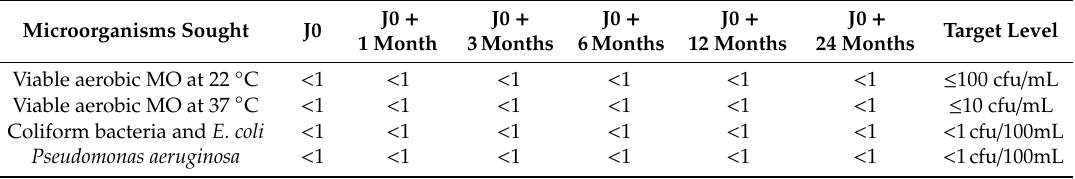
Table 2. Results of the output water samples collected from the MDDS at di ff erent times. Microorganisms